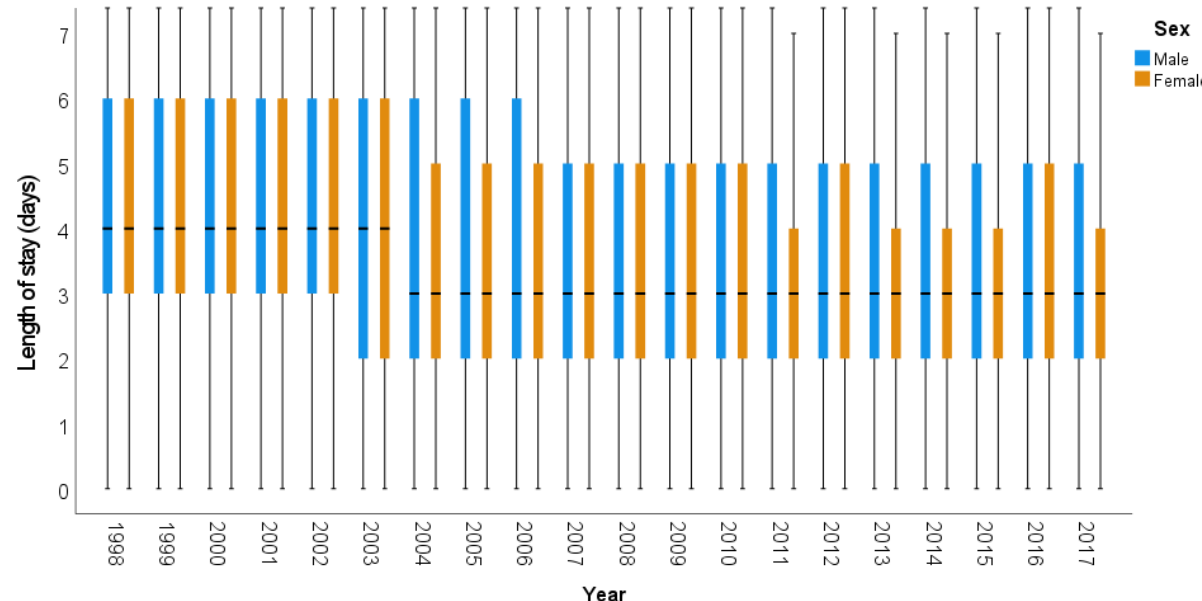
Figure 2. Annual age-standardized rate per 100,000 female (all ages), admitted for acute appendicitis in Spain, 1998 to 2017.